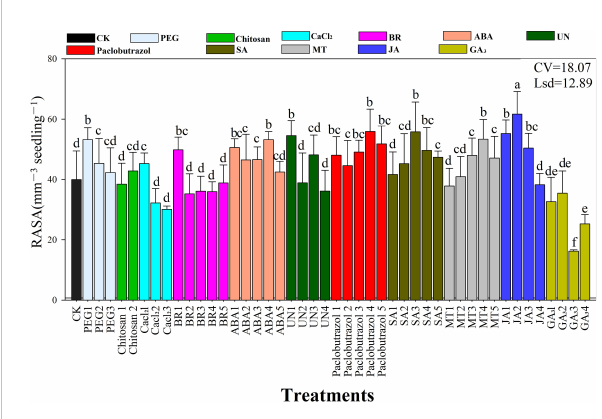
FIGURE 3 Response of root surface area to the seed priming treatments under chilling stress. RASA, root average surface area; CV, coef fi cient of variation; Lsd, least signi fi cant difference. Different lowercase letters indicate signi fi cant differences (P< 0.05). See Table 1 for treatment details. Bars indicate standard